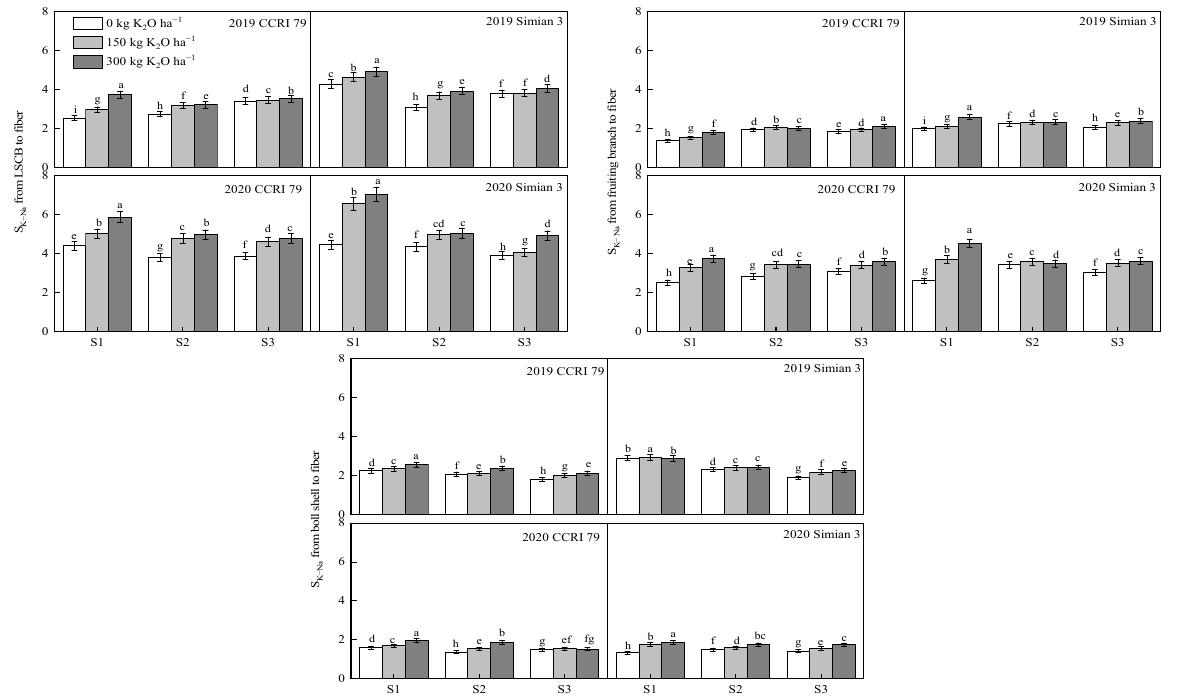
Figure 5. The effect of K application on S KNa at 15 DPA under salt stress. S1, low salinity level; S2, moderate salinity level; S3, high salinity level. Different letters denote significant differences between the mean values ( p <